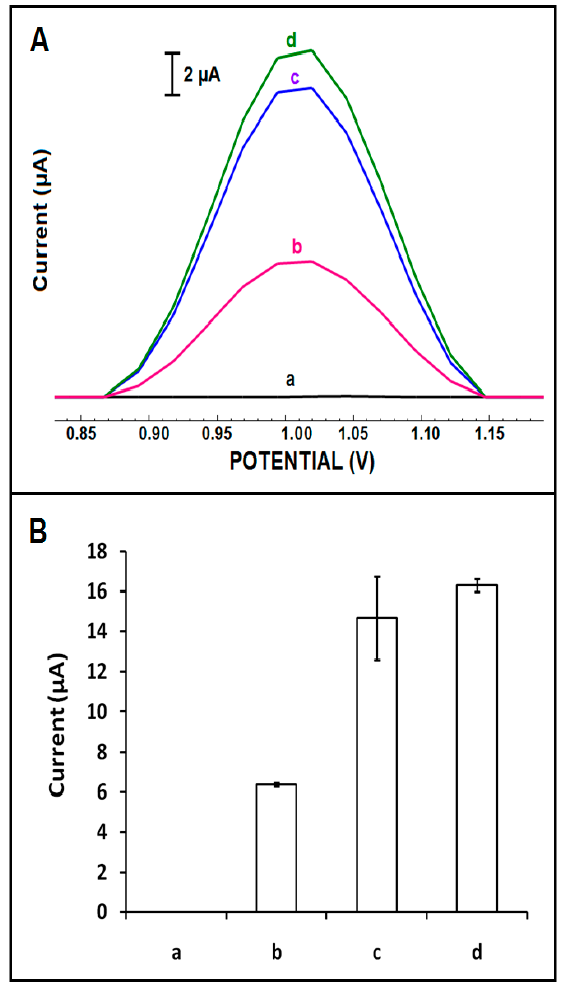
Figure 5. ( A ) DPVs and ( B ) histograms representing control experiment of (a) CoPc-IL-PGE in ABS, the guanine oxidation signals of 5 µg/mL, (b) bare (unmodified) DNA probe, (c) PO 4 linked DNA probe, and (d) NH 2 linked DNA probe immobilized CoPc-IL-PGE in the presence of hybridization with its complementary target DNA.